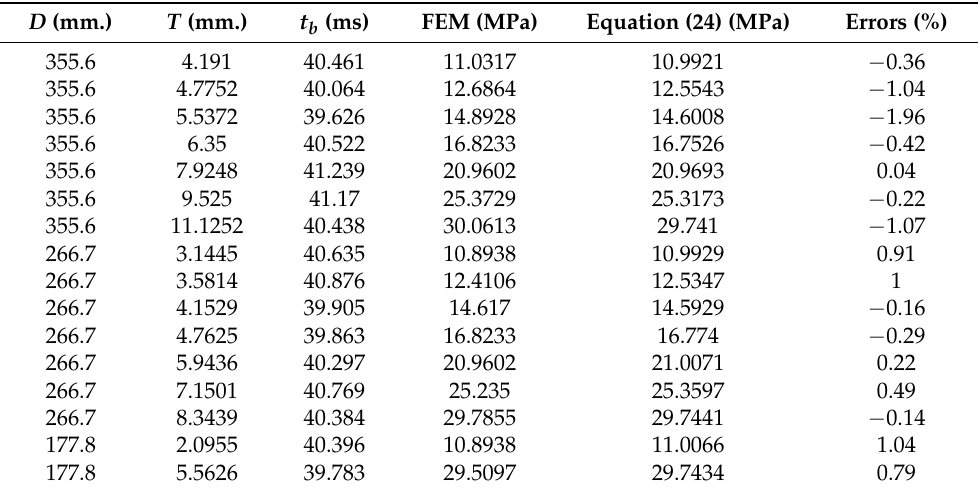
Table A5. Comparisons between the FEM results and the predictions, when t d = 39 ms.